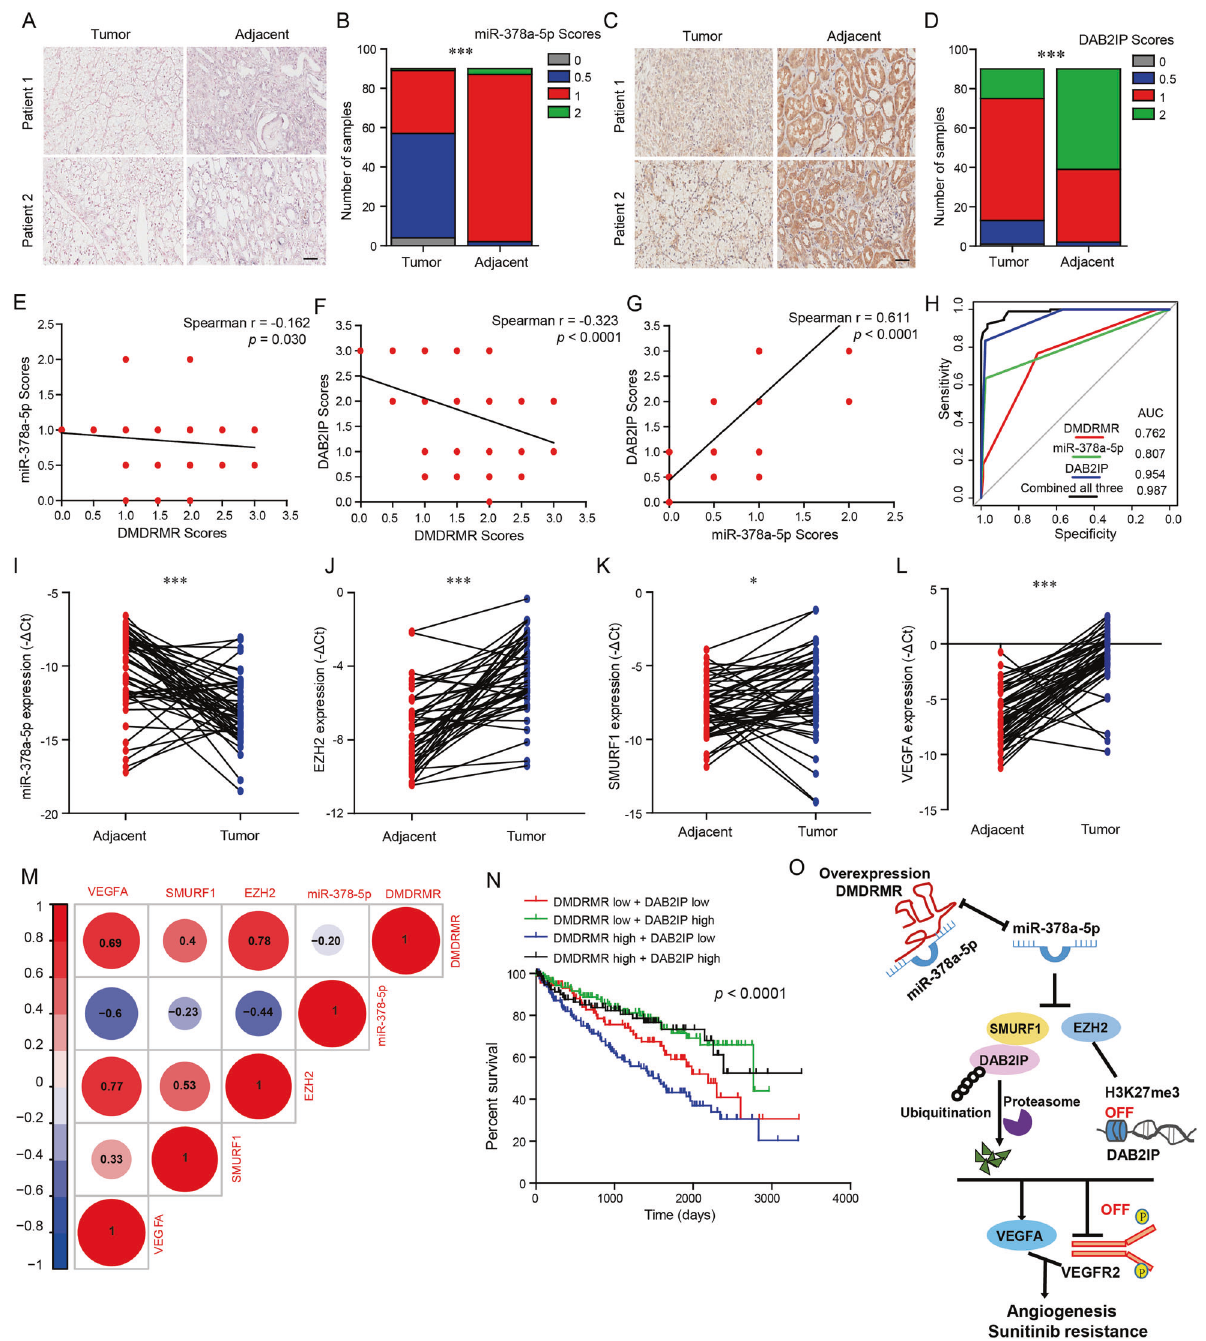
Fig. 8 The correlation between DMDRMR and its ceRNA axis in ccRCC. A , B Representative images ( A ) and scores ( B ) of miR-378a-5p expression from ccRCC and adjacent tissues by ISH assays (scale bars, 50 µm). C , D Representative images ( C ) and scores ( D ) of DAB2IP expression from ccRCC and adjacent tissues by IHC assays (scale bars, 50 µm). E – G Spearman correlation analysis between miR-378a-5p and DMDRMR expression levels ( E ), DAB2IP and DMDRMR expression levels ( F ), DAB2IP and miR-378a-5p expression levels ( G) . H ROC curve analysis for the indicated parameters in ccRCC compared to adjacent tissues using the expression levels of DMDRMR , miR-378a-5p, DAB2IP, and combined their expression levels. I – L The qRT-PCR analysis of miR-378a-5p ( I ), EZH2 ( J ), SMURF1 ( K ), and VEGFA ( L ) expression levels in 48 paired ccRCC and adjacent tissues. Delta cycle threshold ( Δ Ct). M The correlation analysis of DMDRMR , miR-378a-5p, EZH2 , SMURF1 and VEGFA expression levels. N Kaplan – Meier survival analysis was compared among the different combination of DMDRMR and DAB2IP expression. O Proposed model for the DMDRMR/ miR-378a-5p/DAB2IP axis promoting the angiogenesis of ccRCC. The results are presented as mean ± SD. * p < 0.05 and *** p < miR-378a-5p axis inhibits the inactivation of DAB2IP-regualted DAB2IP functions as endogenous inhibitor of adaptive angiogen- VEGFA/VEGFR2 signaling pathway, which can explain our notion esis in part by binding directly to VEGFR2 and limiting PI3K activation that the DMDRMR /miR-378a-5p axis could serve as an angiogenic [25]. Although we did not de fi ne how the DMDRMR /miR-378a-5p/ activator in ccRCC. Given the known function of DMDRMR and miR- DAB2IP axis regulates VEGFA expression, we revealed that DMDRMR /